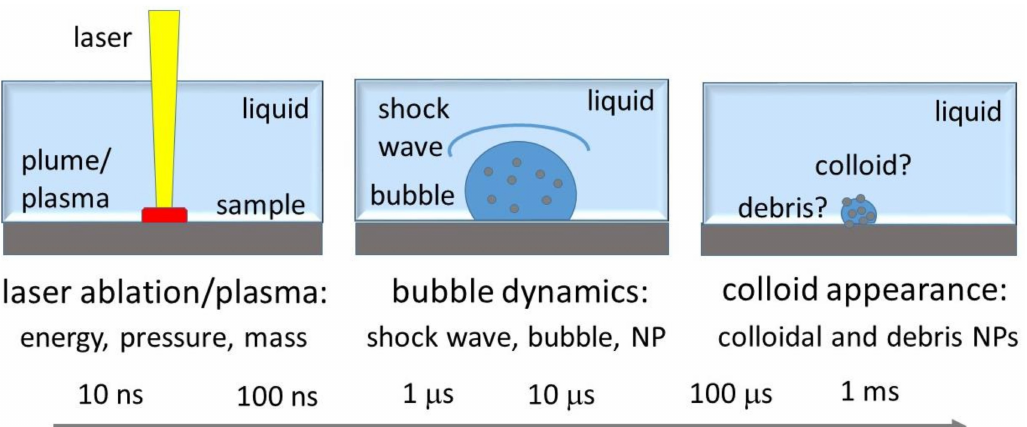
Figure 1. Three basic stages of nanosecond-laser ablation generation of colloidal nanoparticles (NPs) in liquids with their corresponding spatial and temporal